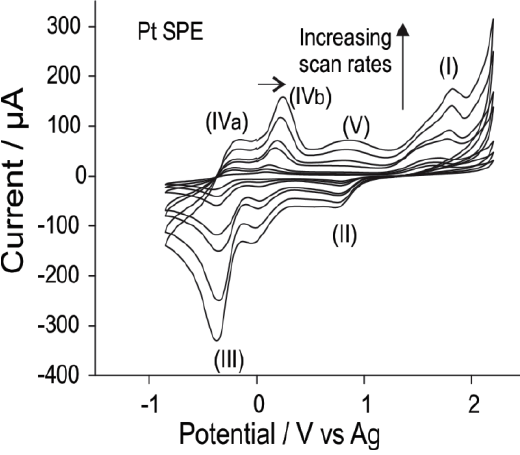
Figure 5. CV (second scan) for the oxidation of 0.15% hydrogen chloride gas (nitrogen fill) on a Pt SPE in [C 2 mim][NTf 2 ] at varying scan rates (0.05–3